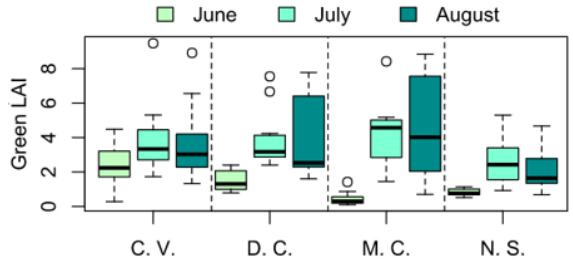
Figure 5. The green LAI during the season for individual